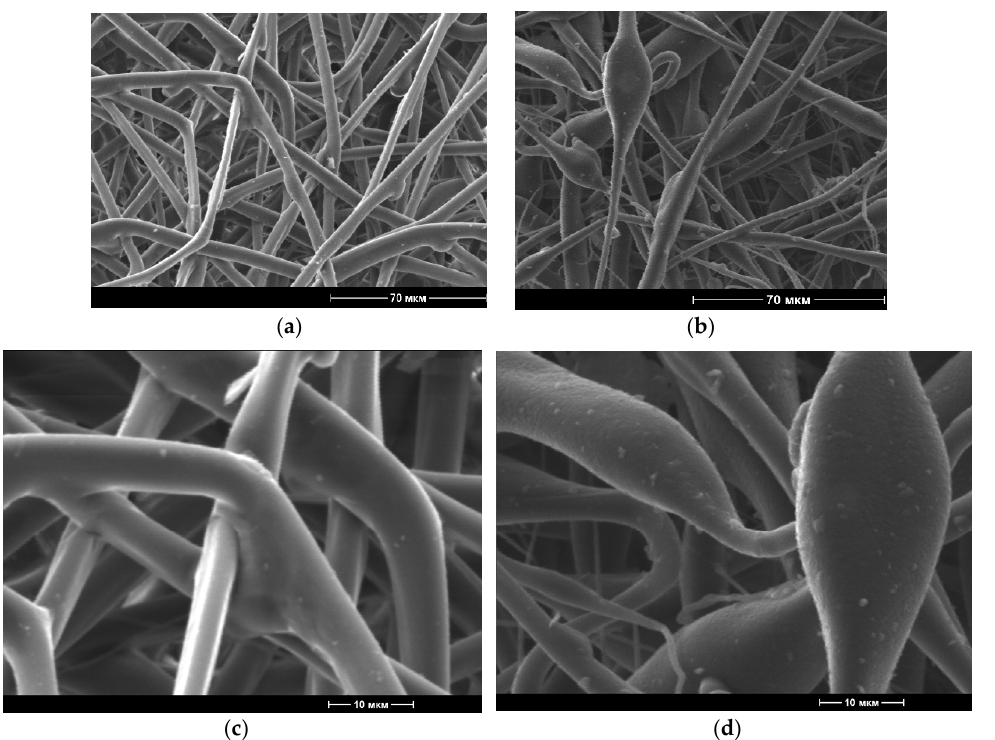
Figure 1. Scanning electron micrographs of PLA ( a , c ) PLA/NR fibers with 15 wt.% ( b , d ) of NR content at different magnification.